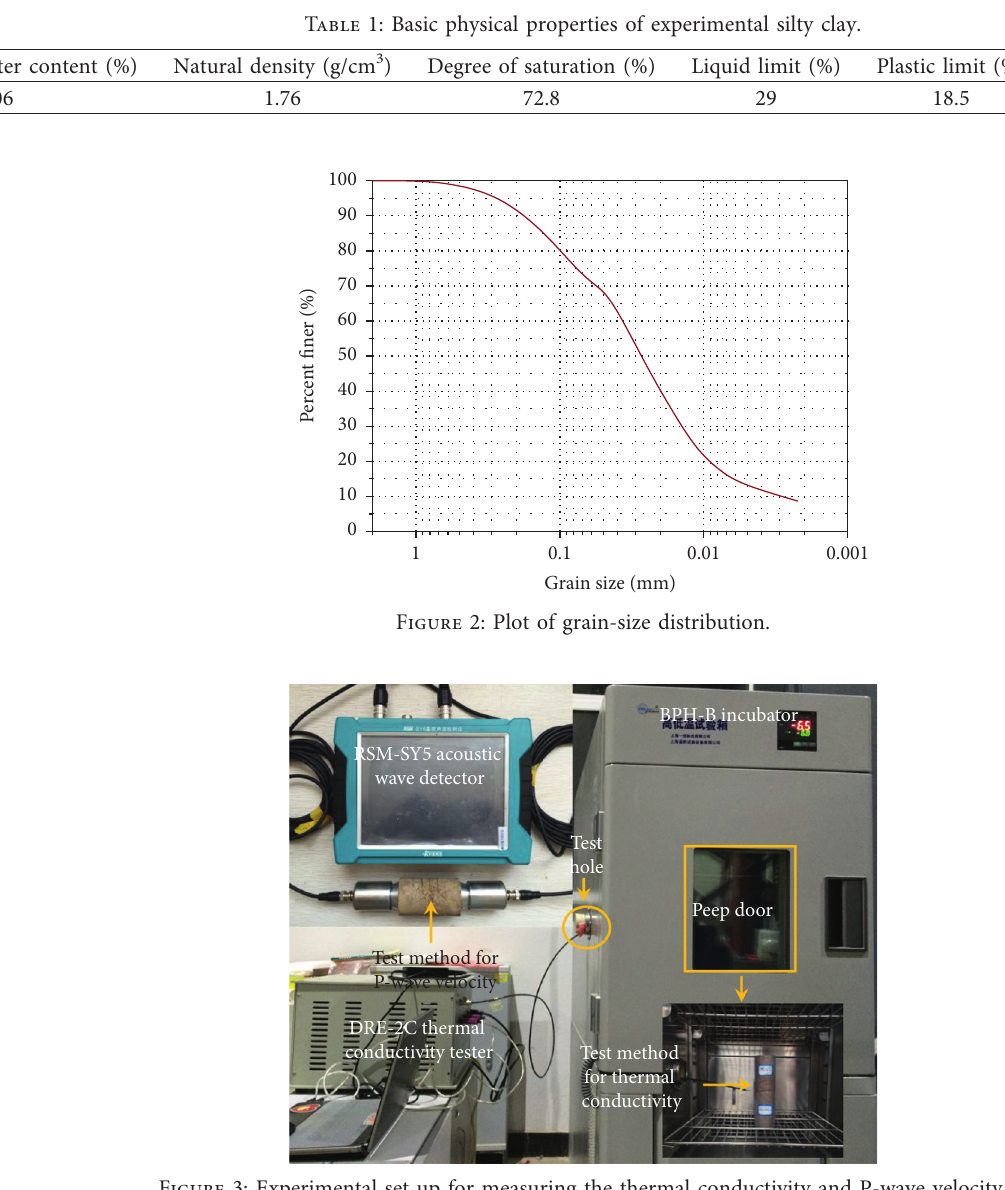
Figure 3: Experimental set up for measuring the thermal conductivity and P-wave